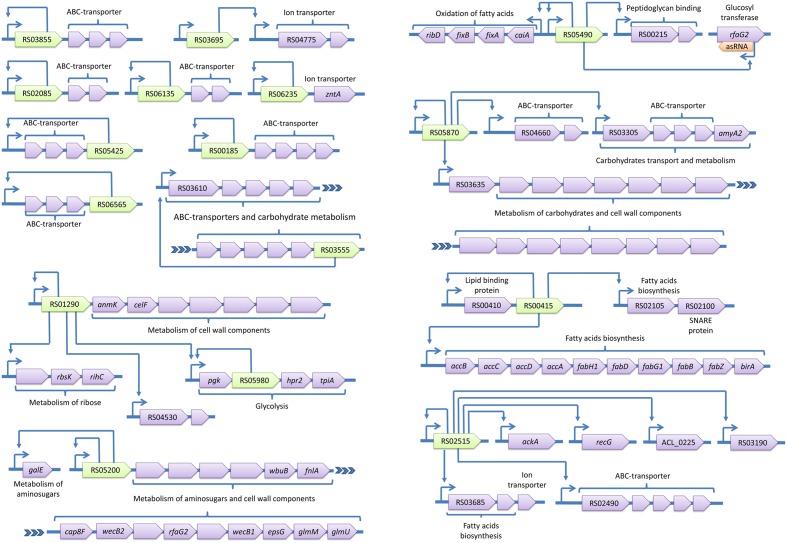
Transcriptional regulons of A. laidlawii (continued). Green genes represent TFs with predicted binding sites, violet genes are target genes and orange genes are non-transcriptional regulators. TSSs of operons are shown by arrows upstream of the genes; other arrows show predicted regulatory relationships between genes.